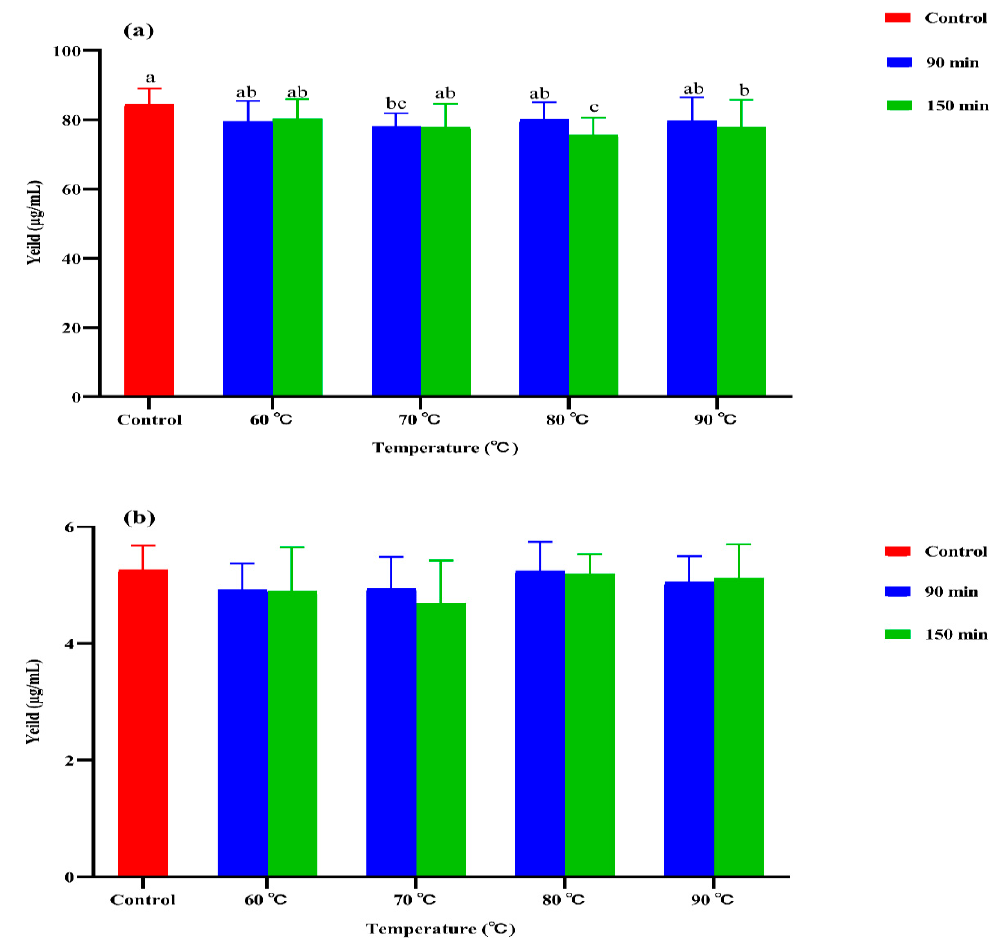
Figure 2. CLA yields of the samples under different methylations ( n = 8). ( a ) C18:2 c9,t11, ( b ) C18:2 t10,c12. The samples only treated by base-catalyzed methylation (50 °C for 20 min) were used as control. The additional acid-catalyzed methylation was performed under different reaction temperatures (60 °C, 70 °C, 80 °C, and 90 °C) and durations (90 min and 150 min). Different lowercase letters indicate a significant difference ( p < 0.05). Error bars are standard deviations.